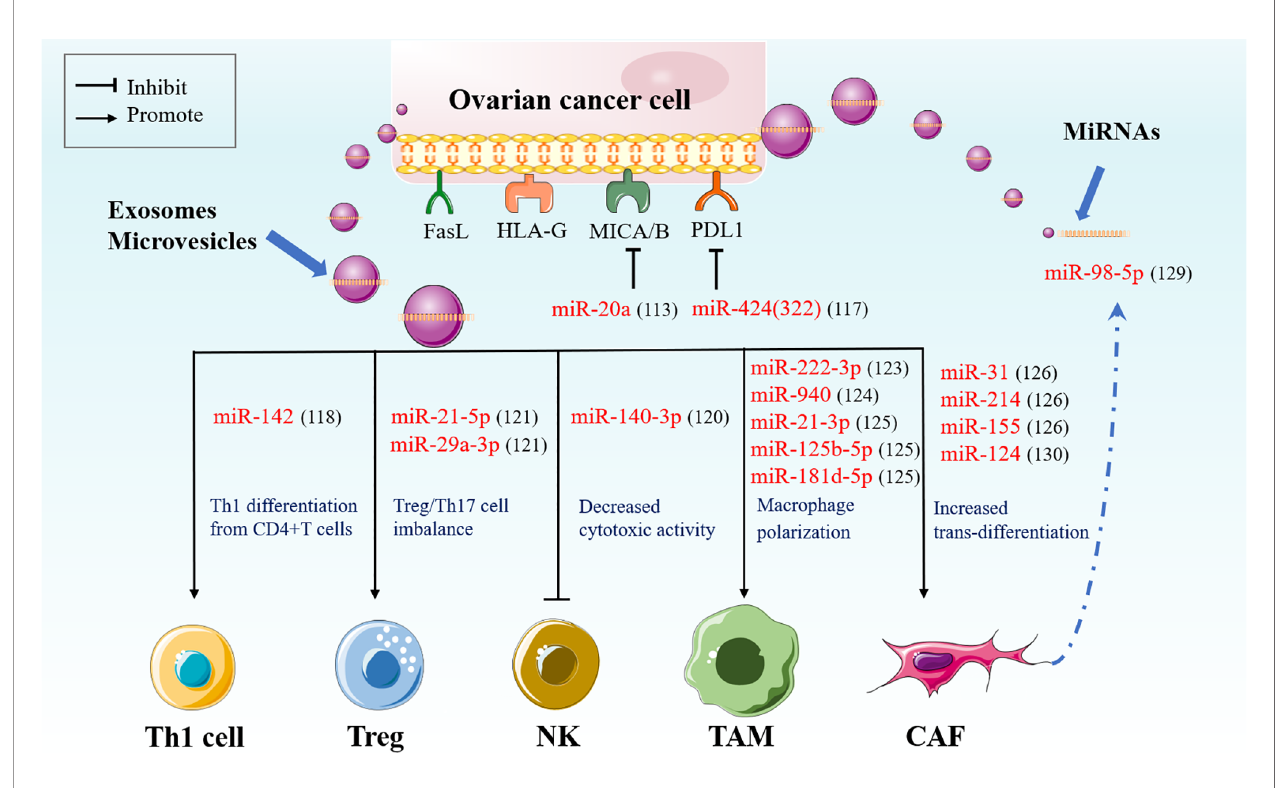
FIGURE 2 | miRNA mediated immune escape in OC. Immunological miRNA can suppress MHC class I chain-related molecules A and B (MICA/B) and immune checkpoint PDL1. OC cells-derived miRNAs can regulate immune evasion via exosomes or vehicles. OC cells-derived miRNAs promote Th1 differentiation from CD4+T cells, blocking NK cells cytotoxicity, inducing the polarization of macrophages toward M2-like phenotype, as well as reprograming normal fi broblasts to CAFs. Moreover, CAFs can secrete exosomal miRNAs to promote the progression of OC. MICA/B, MHC class I chain-related molecules A and B; NK, natural killer cells; TAMs, tumor-associated macrophages; CAFs, cancer-associated fi